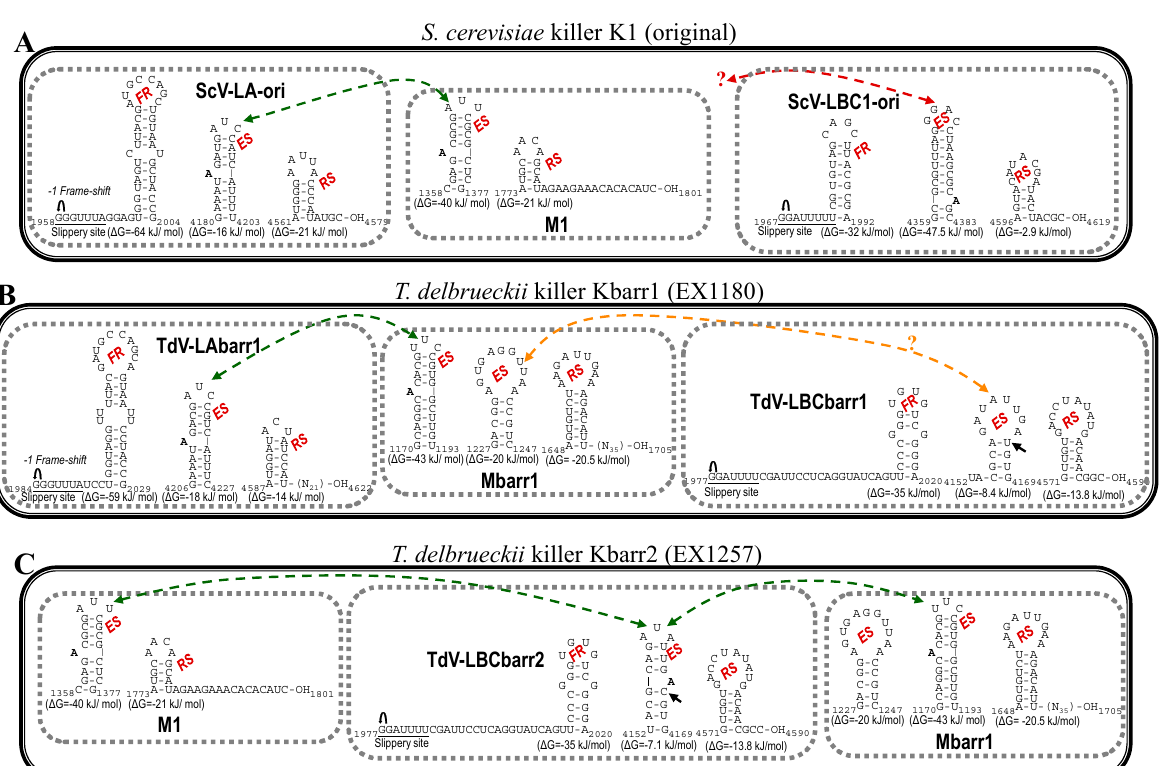
Figure 1. Partial multiple sequence alignment between ScV-LBC1-original, ScV-LBClus4, and TdV- LBCbarr2 (+) strand nucleotide sequences (cDNA). The full sequence alignment is presented in Sup- plemental Material (Figure S1). 5’GAA(A/T)TT conserved motif (5’ conserved), translation initiation (start of Gag and Gag-Pol), termination (stop of Gag or Gag-Pol) codons, ribosome frameshifting site ( − 1 frameshift site), frameshifting associated sequence (stem-loop for frameshift), packaging sig- nal (stem-loop for packaging), and replication signal (stem-loop for replication) are indicated, shaded and/or underlined in the nucleotide sequence. Different residue in LBCbarr2 with respect to LBCbarr1 virus is yellow shaded. Asterisks (*) indicate identical nucleotide positions. The secondary structures of the putative cis signals for frameshifting, packaging, and rep- lication of TdV-LBCbarr2 are displayed at the right of the sequence panel.